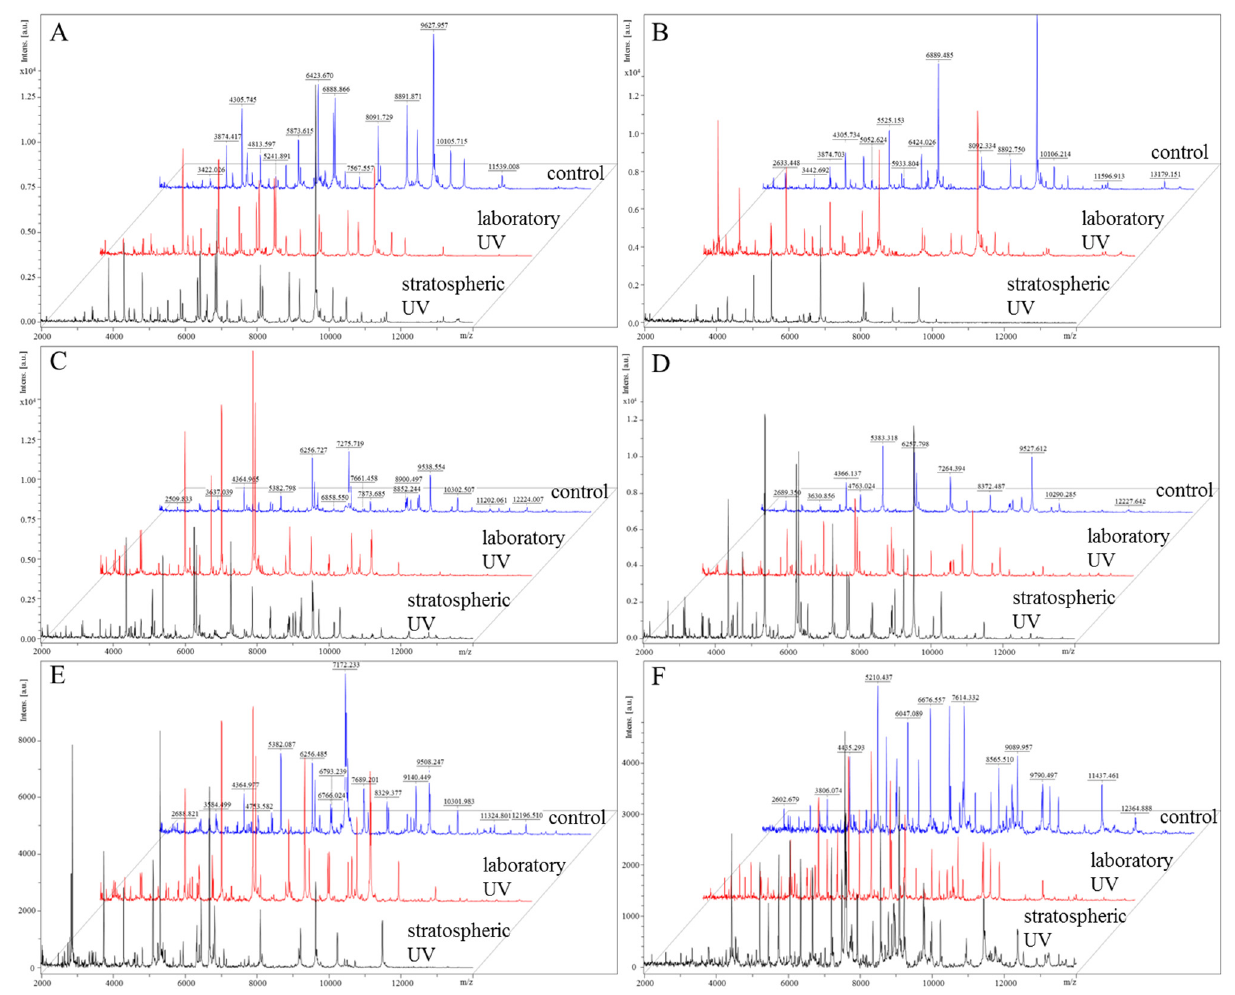
Figure 6. Comparison of MALDI-TOF MS spectra of bacteria without UV exposure, after exposure to the laboratory and stratospheric UV: ( A ) S. aureus ; ( B ) MRSA; ( C ) E. coli ; ( D ) S. typhimurium ; ( E ) P. mirabilis ; and ( F ) P. aeruginosa . Data were collected in the m/z range 2.000–20.000. For MALDI-TOF analysis, 1 µL of extract of each